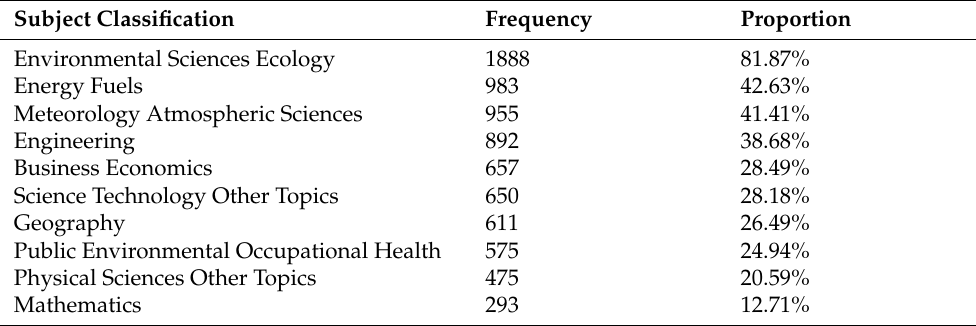
Table 1. Subject classification of the Web of Science.